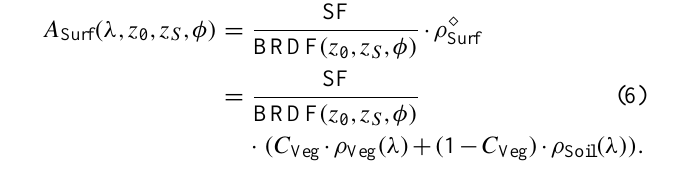
Fig. 4. Main surface reflectance spectra used for the surface re- flectance model such as “green vegetation” and “bare soil” in com- parison with experimental data. The high reflectance of bright soil causes additional restrictions for the aerosol